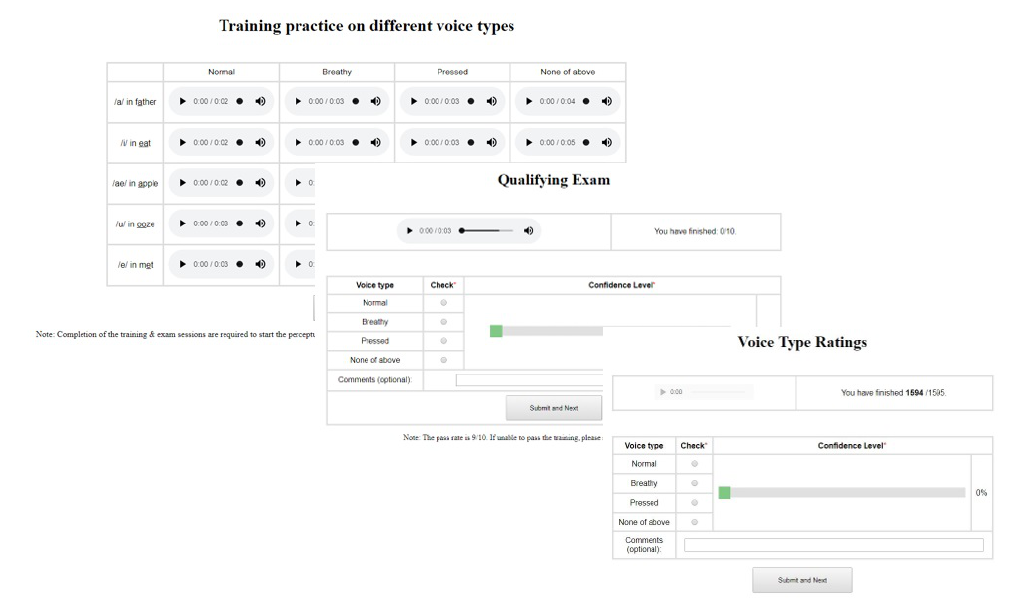
Figure 3. Screenshots of the online voice type assessment